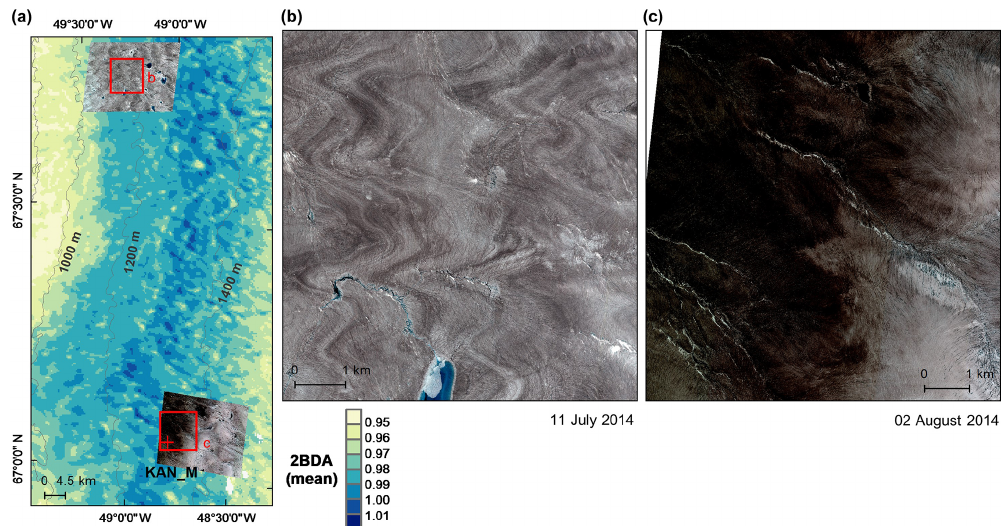
Figure A3. Average 2BDA index (2004–2011) for a subset of our study area (a) , and comparison between WorldView-2 imagery (© 2014 DigitalGlobe, Inc.) over a dark ice site with low 2BDA index at 1000–1200m elevation (b) and a dark ice site with high 2BDA index at 1200–1400m elevation (c) . The WorldView-2 image in (b) illustrates the wavy pattern that Wientjes and Oerlemans (2010) suggested was caused by ancient ice outcropping. The WorldView-2 images are radiometrically calibrated (top-of-atmosphere radiances) and orthorectified and are shown as a true color composite (red channel: 659nm band; green channel: 546nm band; blue channel: 478nm band).